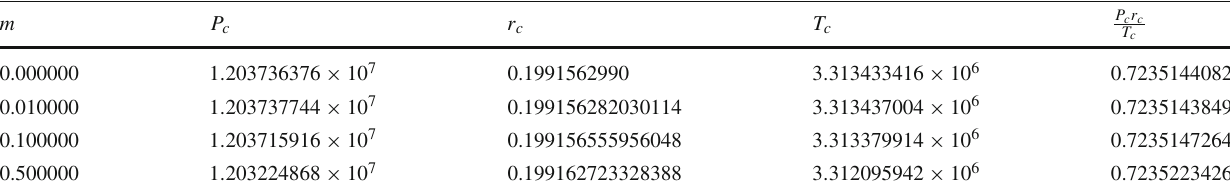
Table 9 Hyperbolic black holes: k = − 1, d = 7, q = 1, c 0 = c 1 = c 2 = c 3 = c 4 = 1 and α = 0 . 01 m P